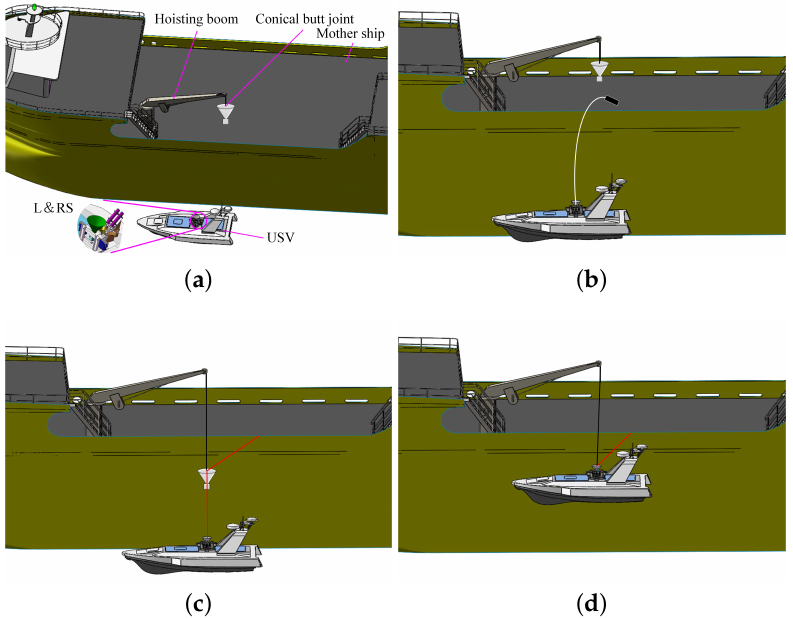
Figure 2. Operation process in recovering a USV. ( a ) Homing and aiming phase. ( b ) Launching phase. ( c ) Docking phase. ( d ) Lifting